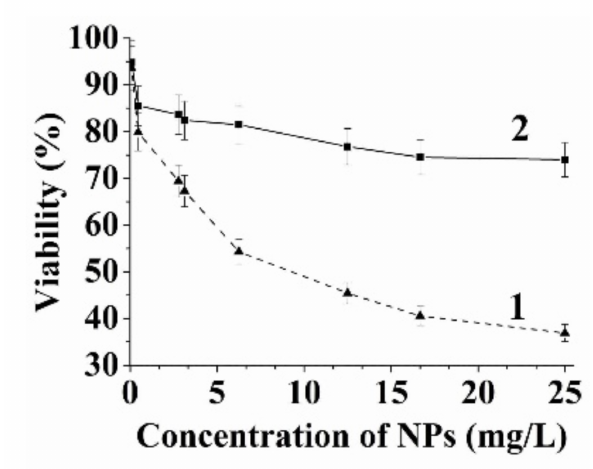
Figure 11. Cell viability of test culture of Chlorella vulgaris Beijer in the environment of CoFe 2 O 4 nanoparticles (1) before and (2) after one gold deposition